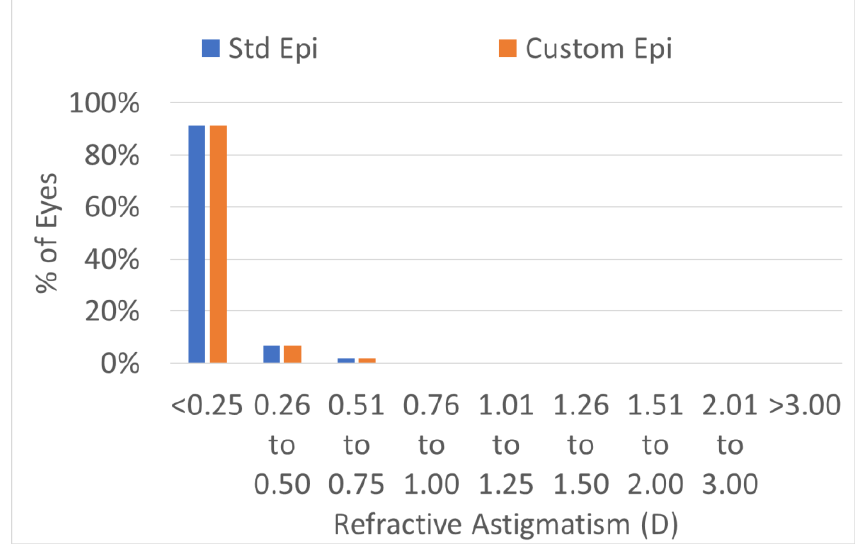
Figure 3. Postoperative refractive astigmatism. Postoperative refractive astigmatism was 0.28 ± 0.09 D in both groups ( p = 0.5). The predictability of the treatments was the same in both groups. In 100% of the eyes, the postoperative refractive astigmatism was within 0.5 D of the intended target.